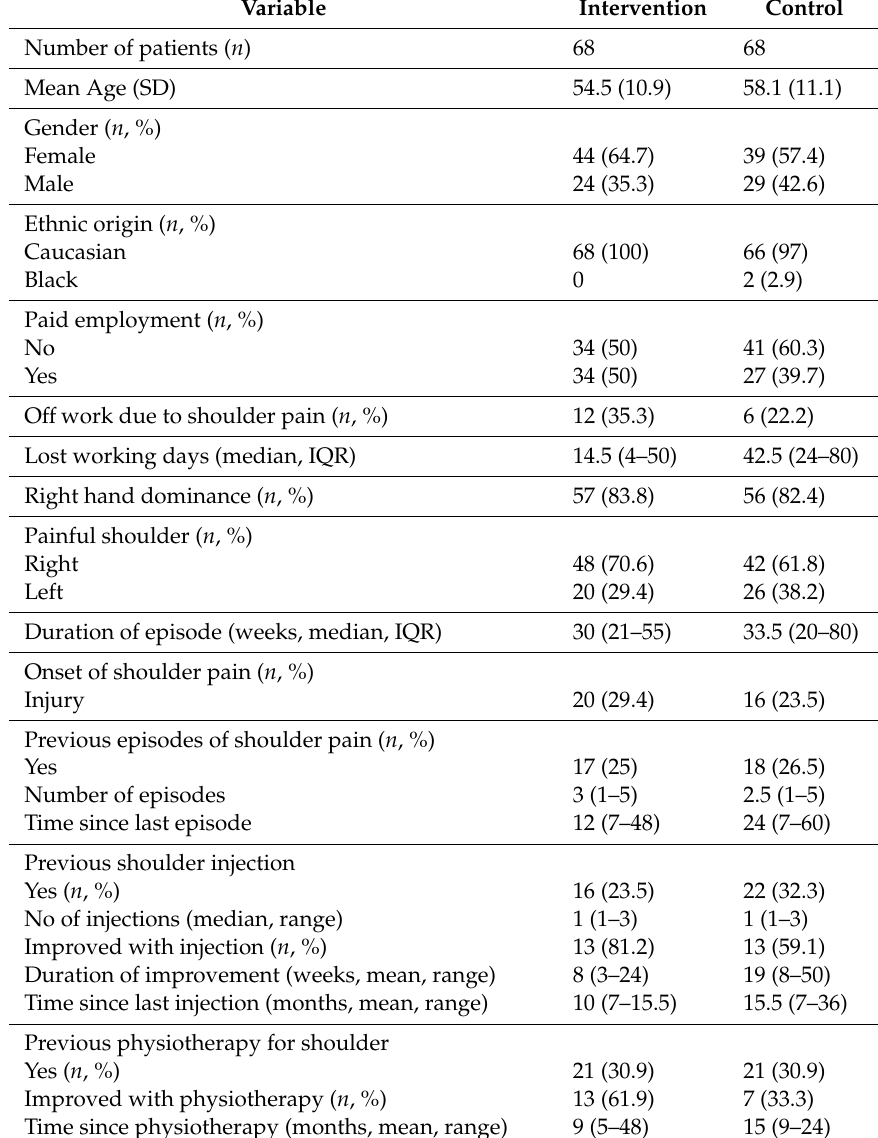
Table 2. Baseline